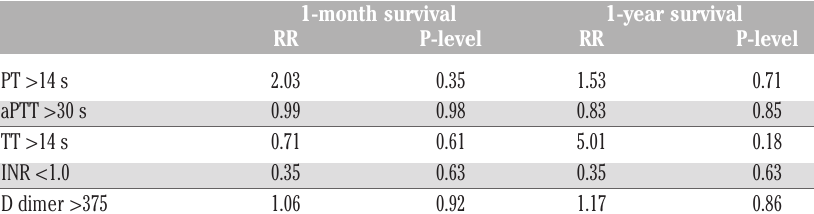
Table 4. Prognostic role of hemostatic parameters and tumor